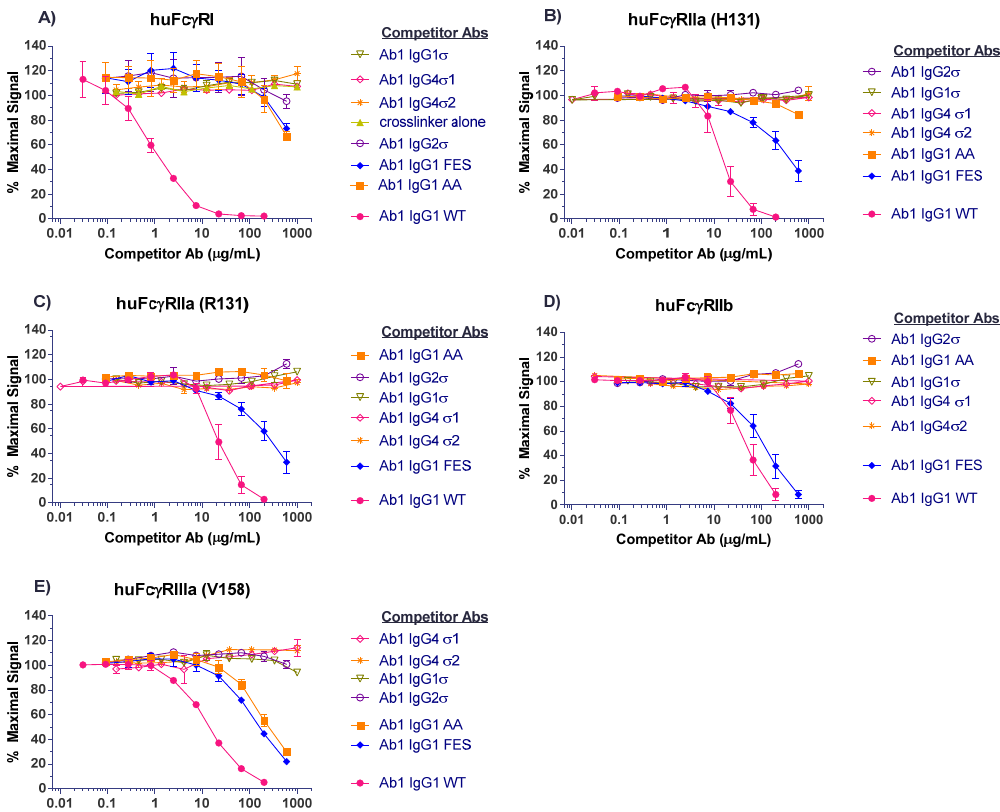
Figure 3. Testing for interactions of cross-linked huIgG variants with Fc γ receptors. Binding of huIgG Ab1 (anti-TNF α ) molecules to human Fc γ Rs was assessed using AlphaScreen bead assays in a competitive format. To increase sensitivity of the assays, test samples were cross-linked to introduce binding avidity by using a goat F(ab (cid:48) ) 2 anti-huIgG F(ab (cid:48) ) 2 -specific fragment in 1:1 molar ratio with the test